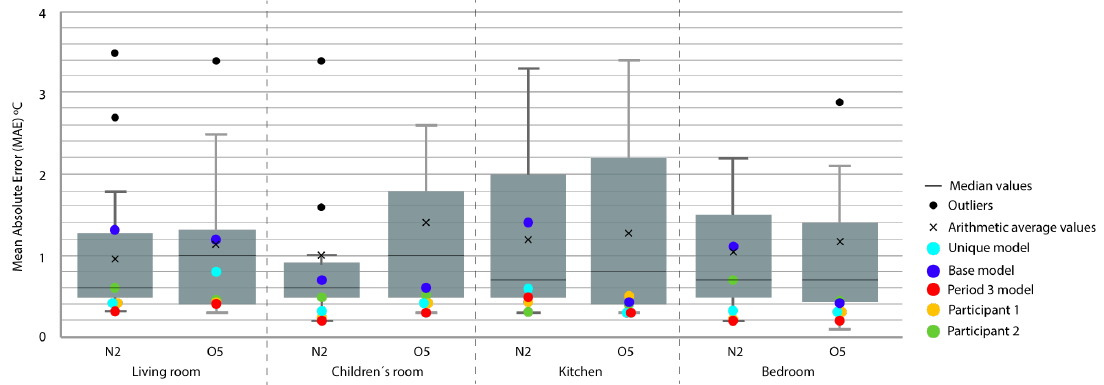
Figure 7. Temperature MAE for Period 3 (Randomly-Ordered Logarithmic Binary Sequence